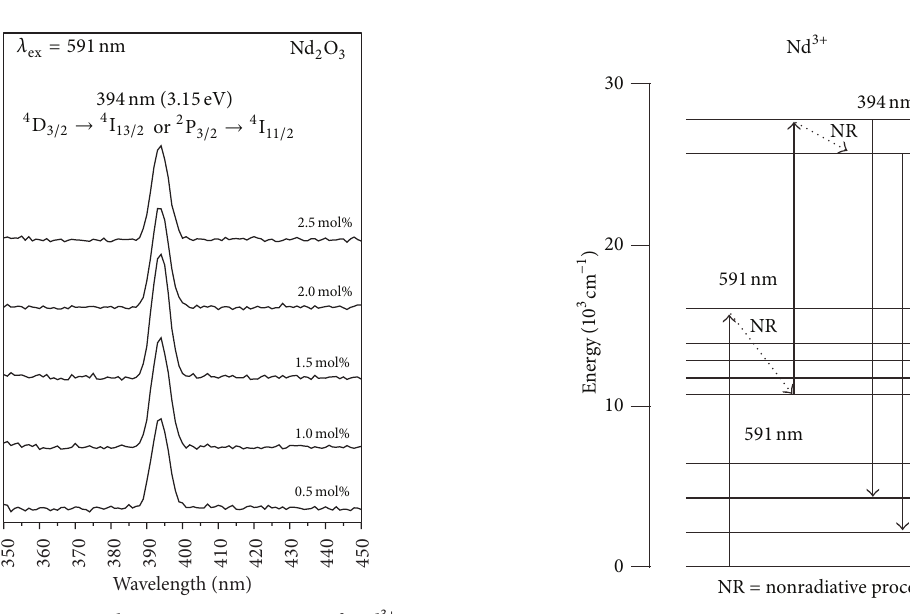
Figure 5: Energy levels and possible transition pathways of Nd 3+ ions in Bi 2 O 3 –BaO–B 2 O 3